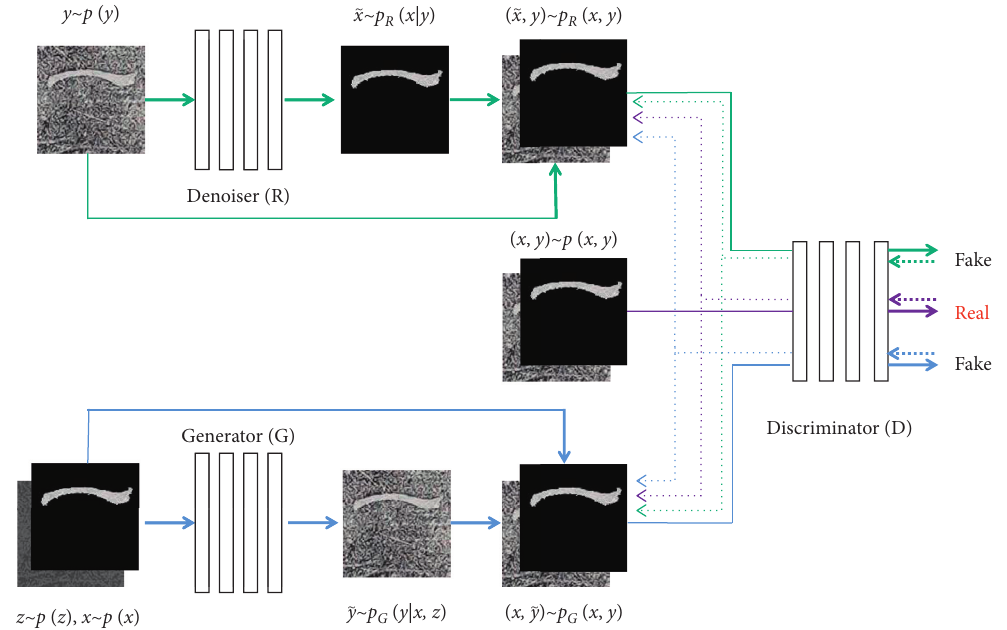
Figure 2: The model of stone inscription image generation based on improved